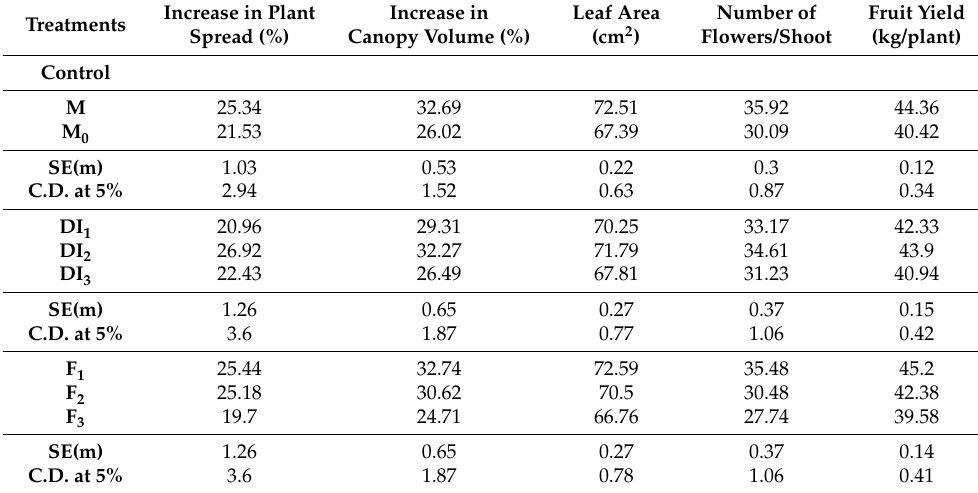
Table 2. Effect of plastic mulch, drip irrigation, and fertigation system on the plant growth dynamics and fruit yield of